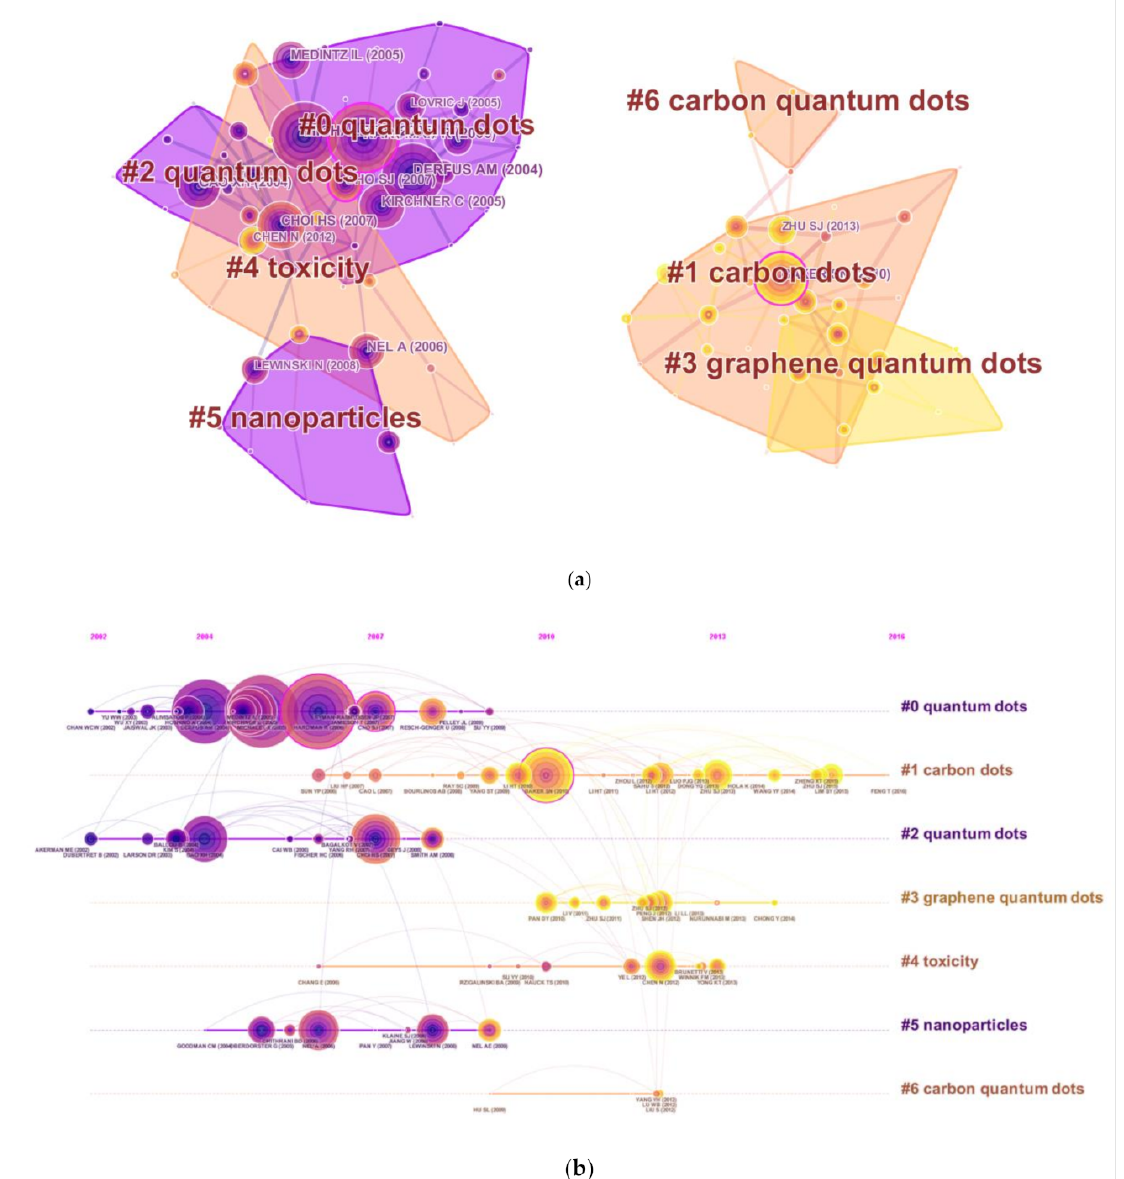
Figure 6. The analysis of references. ( a ) Co-citation map of references from publications on QDs toxicity research; ( b ) Co- citation map (timeline view) of references from publications on QDs toxicity